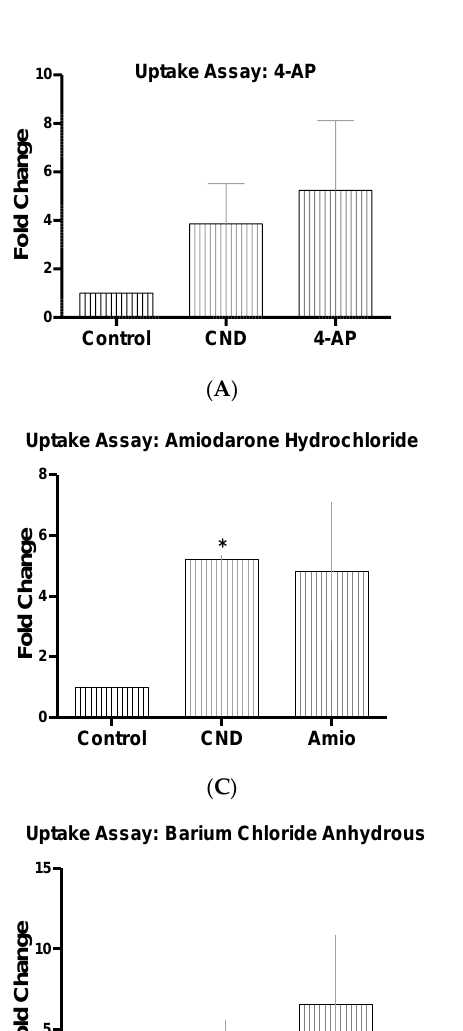
fluorescent intensity ( p > 0.05). Other endocytosis disrupting inhibitors were also tested (Figure 9A–C) and demonstrated no significant change in fluorescence of CNDs ( p > 0.05).